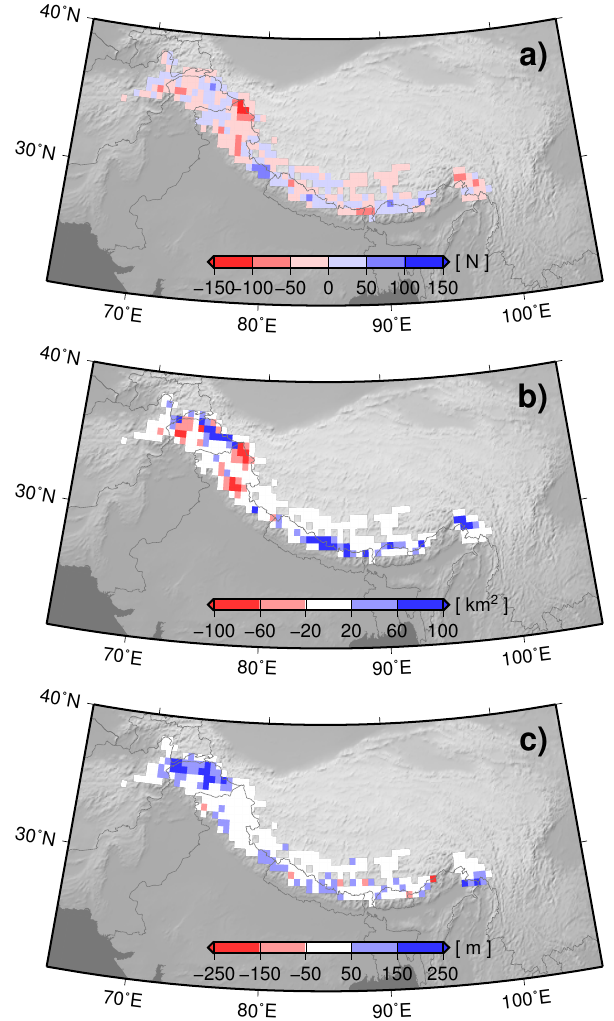
Figure 16. Differences among (a) glacier number, (b) glacier area, and (c) area-weighted mean median elevation in the ICIMOD in- ventory and GGI (i.e. ICIMOD − GGI) for each 0.5 ◦ grid cell in the Hindu Kush–Himalaya range. Calculations were based on the GGI in the same area as the ICIMOD glacier inventory. Median elevations of glaciers for both inventories were derived from the GDEM2.